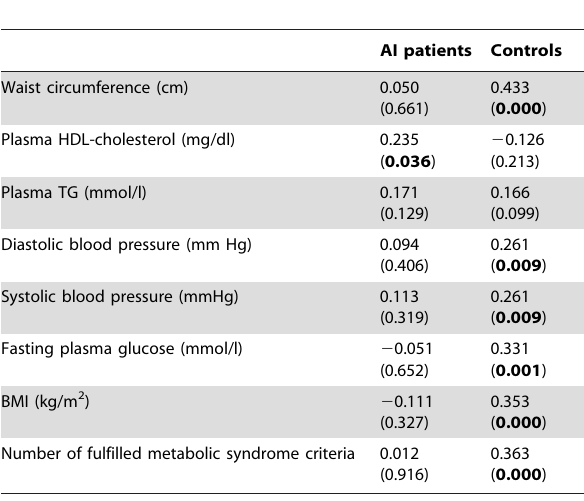
Table 4. Correlation of different parameters of metabolic syndrome with the age of AI patients and controls.